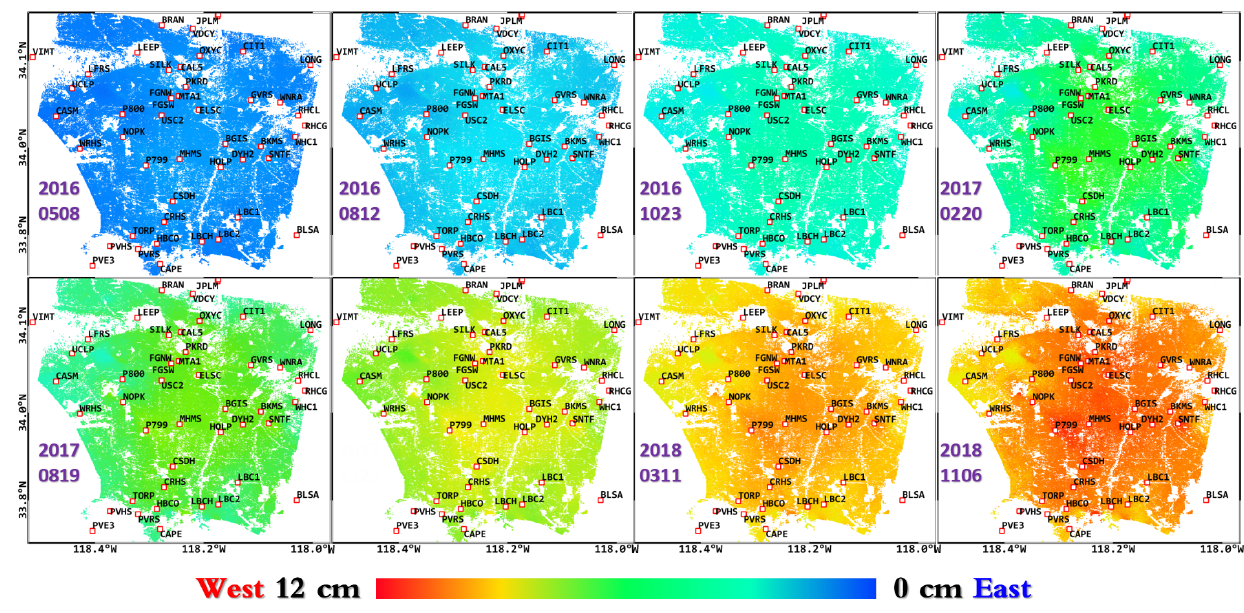
Figure 9. East–west deformation time series maps obtained by SM-Kalman. GNSS sites are repre- sented by red